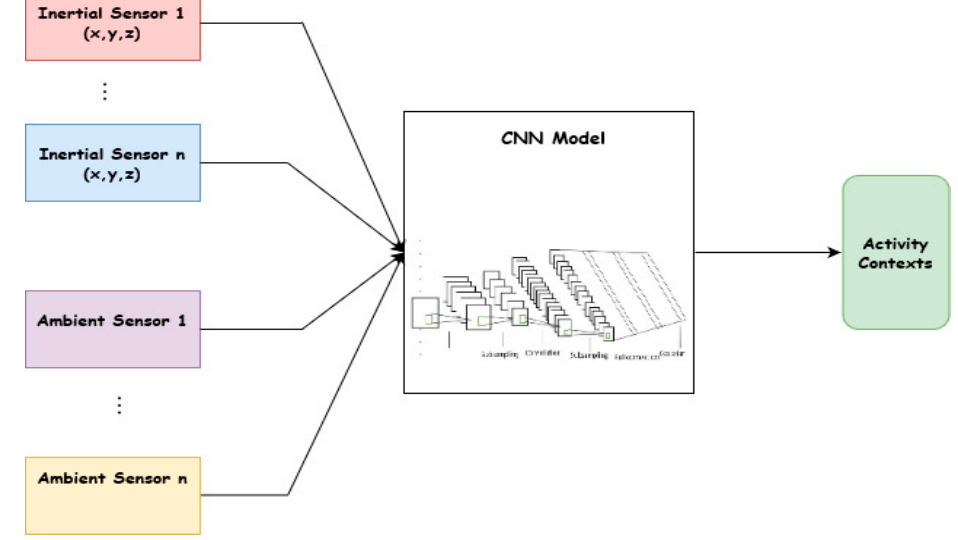
Figure 2. Inertial and ambient sensing model.